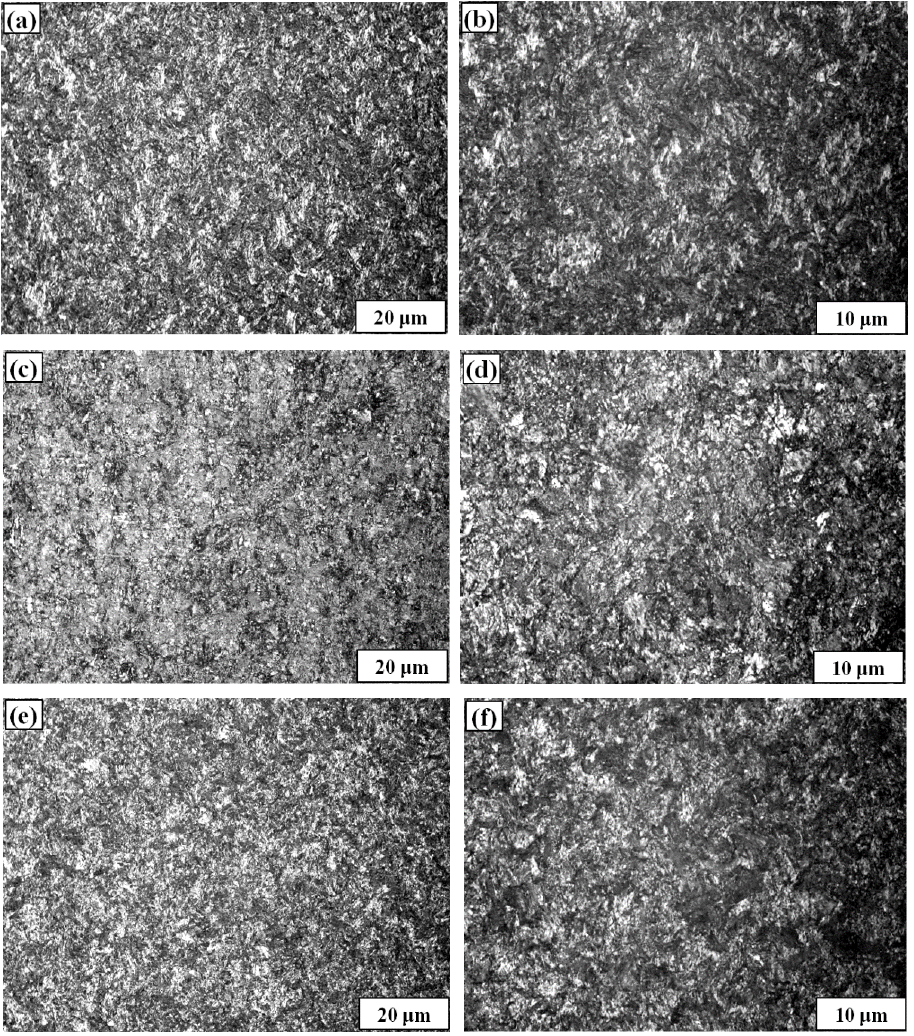
Figure 6. Metallographic microstructures of three high strength wires: Wire A ×500 ( a ) and ×1000 ( b ), Wire B ×500 ( c ) and ×1000 ( d ), Wire C ×500 ( e ) and ×1000 ( f ).